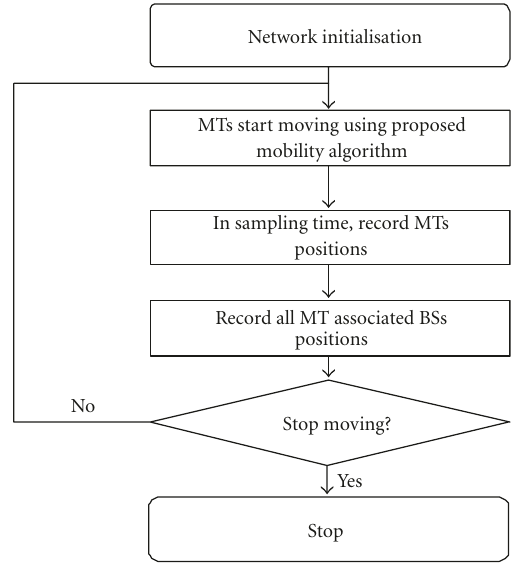
Figure 4: Flowchart of heuristic RN